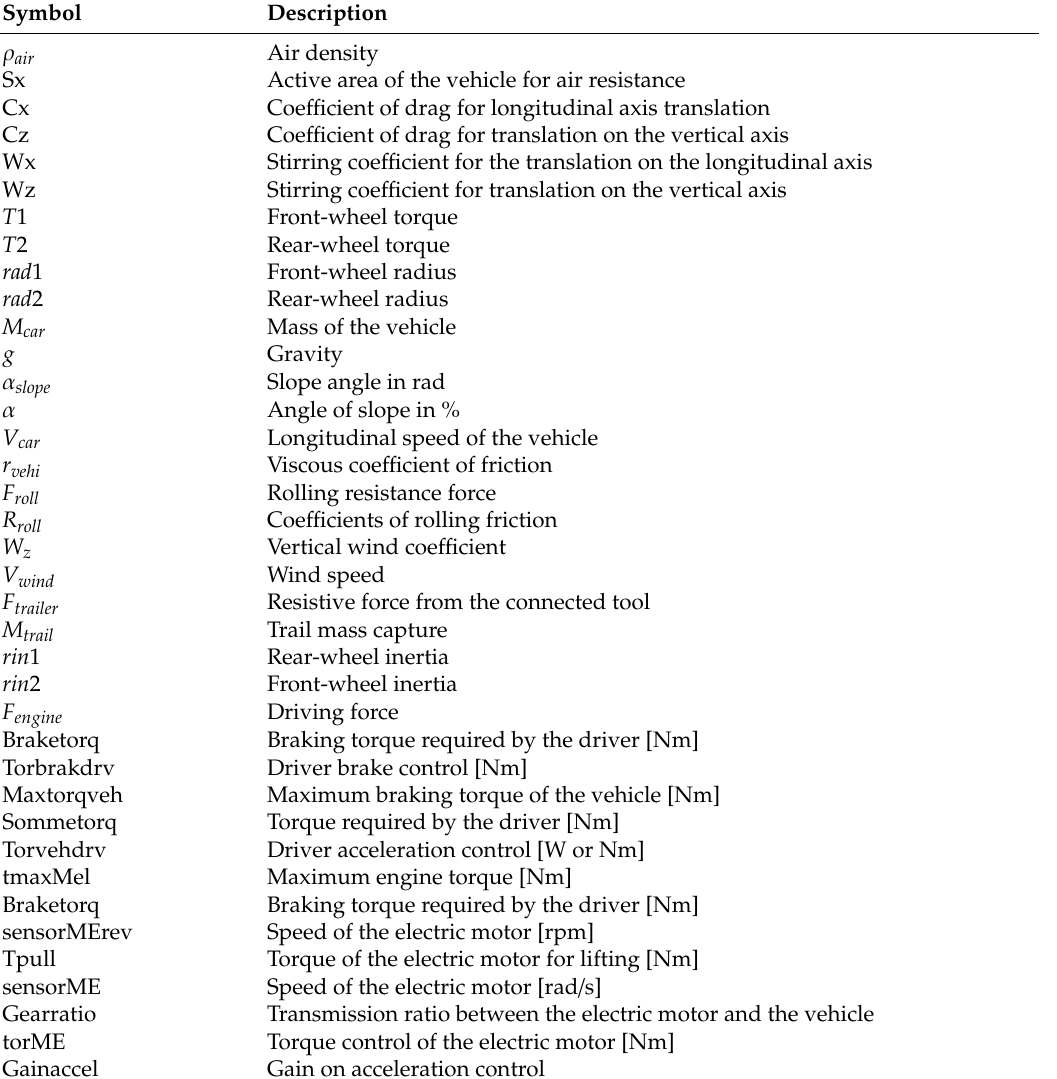
Table 1. Main notation used in this